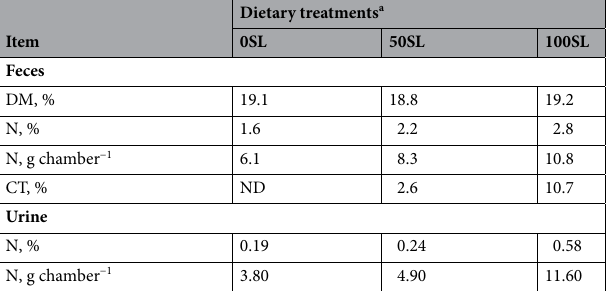
Table 1. Dry matter, nitrogen (N), and condensed tannins (CT) concentration of feces and N concentration composition of urine from beef steers fed three levels of inclusion of sericea lespedeza [SL; Lespedeza cuneata (Dum. Cours.) G. Don]. ND not detected. a 0SL: 0% inclusion sericea lespedeza hay (100%